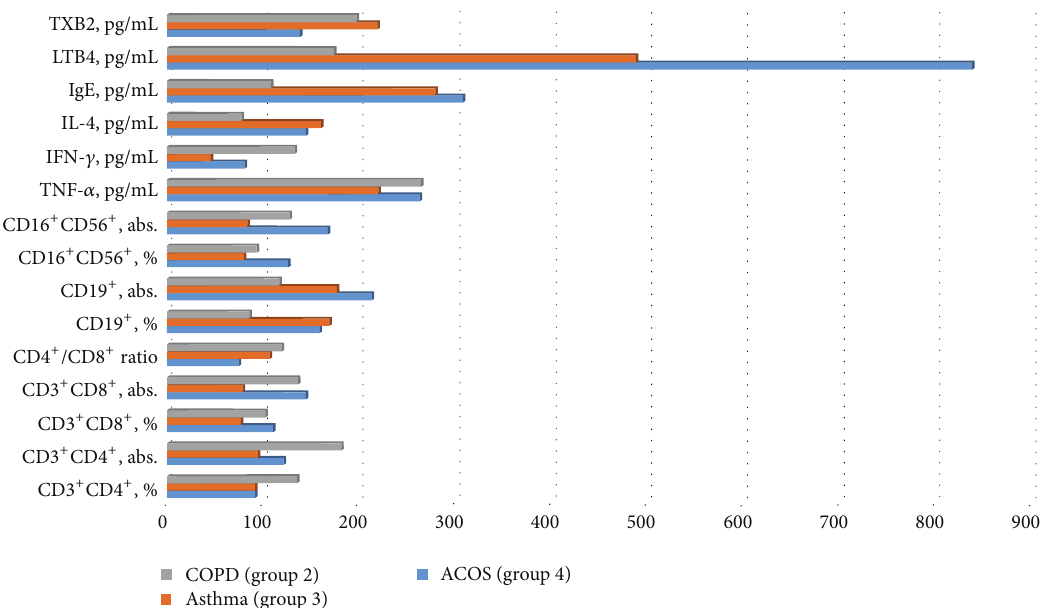
Figure 1: The changes in immune status for patients with COPD, asthma, and